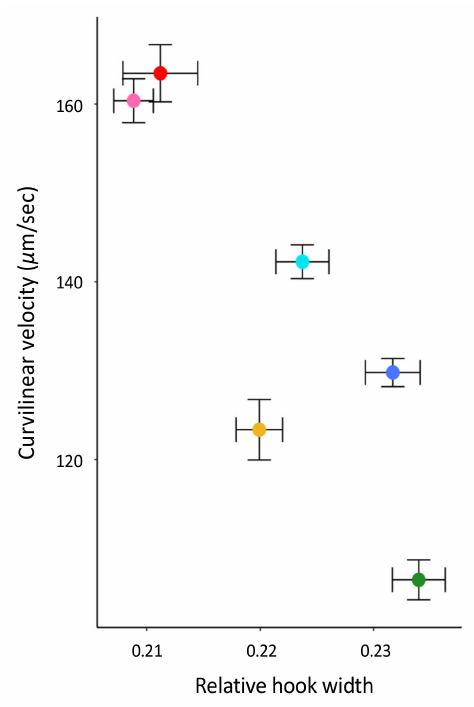
Figure 4. Association between relative apical sperm hook width and sperm velocity by species. Standard error bars for both traits are shown in black, and dots denote species’ mean with same colors as Figure 2. Note truncated y